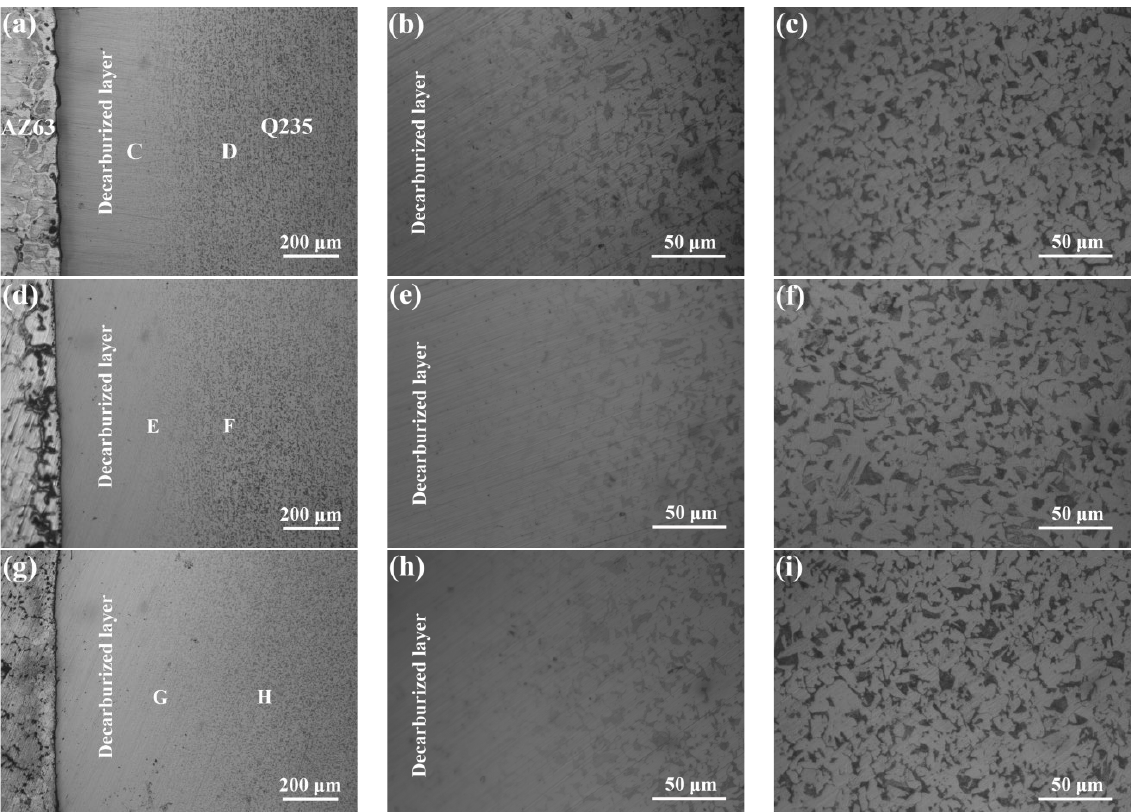
Figure 5. Optical micrographs of the interfacial of ( a ) AZ63/Q235, ( d ) AZ63/galvanized Q235, and ( g ) AZ63/galvanized Q235 + T6; ( b ) magnified image of the region C, ( c ) magnified image of the region D, ( e ) magnified image of the region E, ( f ) magnified image of the region F, ( h ) magnified image of the region G, and ( i ) magnified image of the region H.